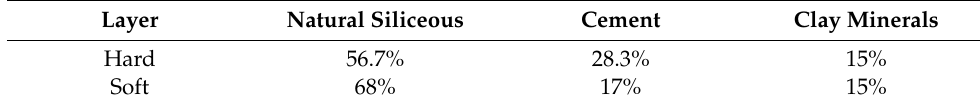
Table 1. The mixtures composition ratio of the hard and soft layers. Layer